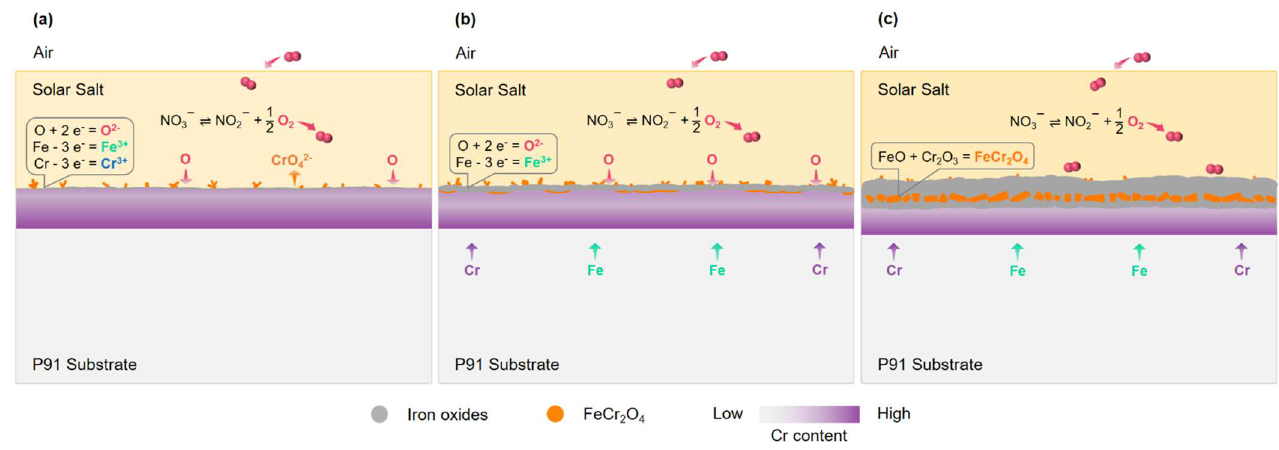
Figure 11. Schematic of the corrosion process of P91 alloy exposed to Solar Salt at 565 °C for 15 days. ( a ) Initial stage, ( b ) Oxide growth stage, ( c ) Internal oxidation stage.